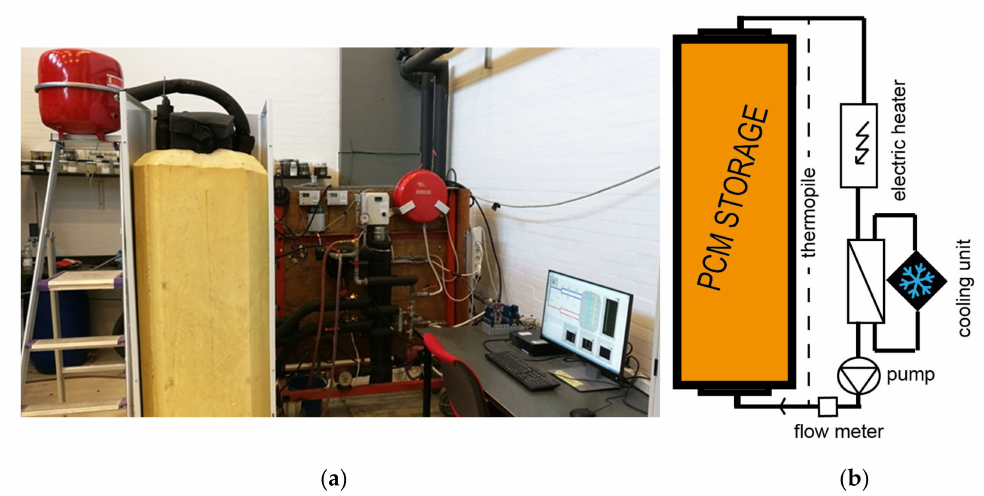
Figure 22. Testing device “DTU full scale”: PCM heat storage test facility at DTU ( a ), schematic of charge and discharge loop ( b